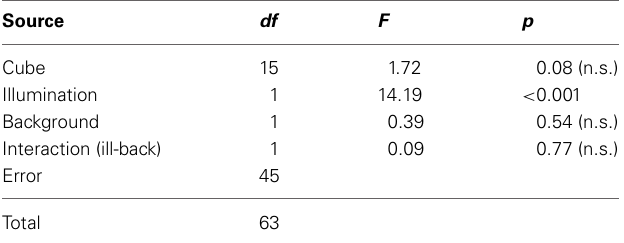
labeled experimental condition averaged across cubes. Error bars are s.e.m. across cubes ( n = 16). In both (A) and (B) variability was defined as the average distance in color space space between each observer’s match and the average chromaticity of matches in that